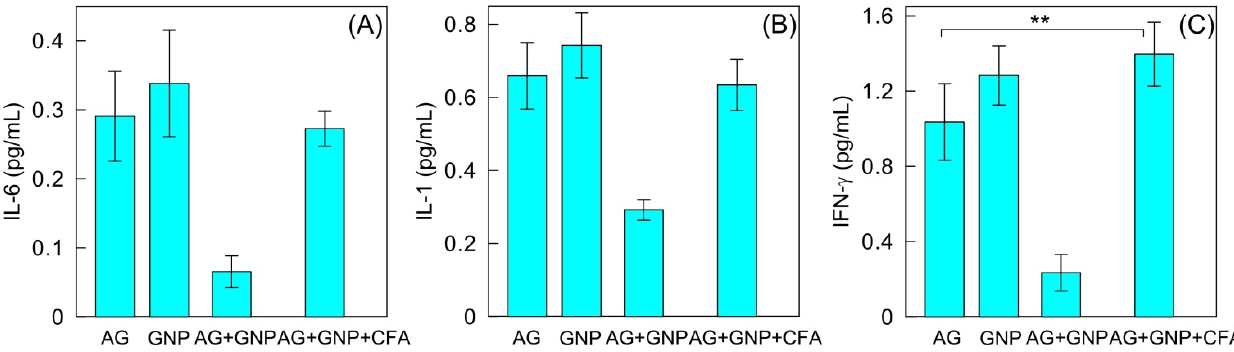
Figure 5. Content of IL-6 ( А ), IL-1I ( B ), and FN- γ ( C ) in the sera of mice after immunization and subsequent tumor transplantation. The difference between the mean values for AG and AG+GNP+CFA variants is statistically significant in panel ( C ). ** means significant difference.